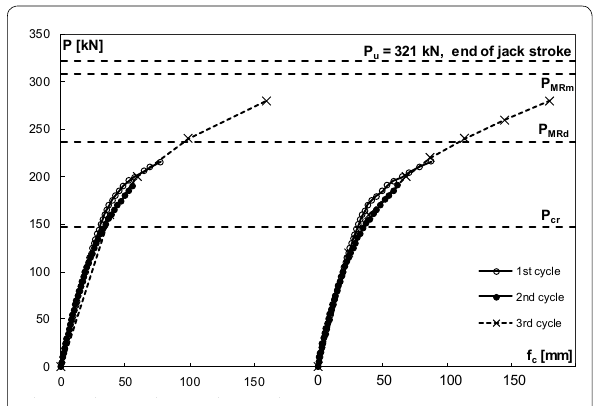
Fig. 4 Flexural tests on specimens H50-f1 and H50-f2: experimental load-midspan deflection curves for the three loading